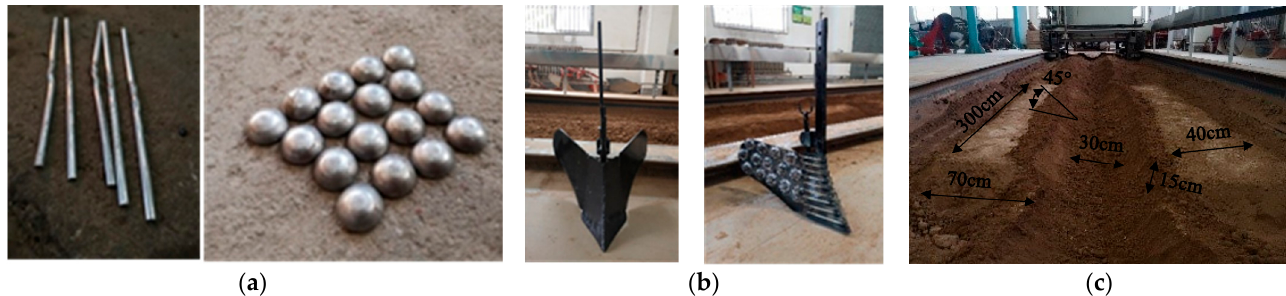
Figure 6. Entity processing and soil trench test of soil cultivator. ( a ) Semicircular corrugated and convex hull structure; ( b ) the traditional soil cultivator and soil cultivator with textured shovel wing; ( c ) the standard ridge.